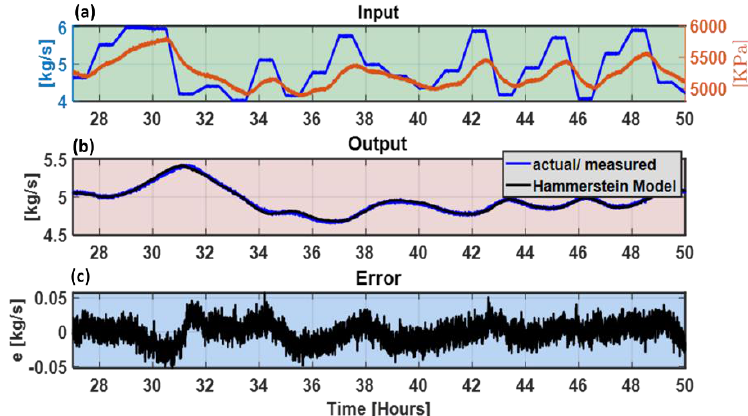
Figure 6. Hammerstein model identification results (training), ( a ) pressure and mass flow rate signals at inlet, used as a model input, ( b ) actual mass flow rate signals at outlet, used as a model output. Estimated mass flow rate sign for given input and output signals, ( c ) modeling errors between actual and estimated mass flow rate.